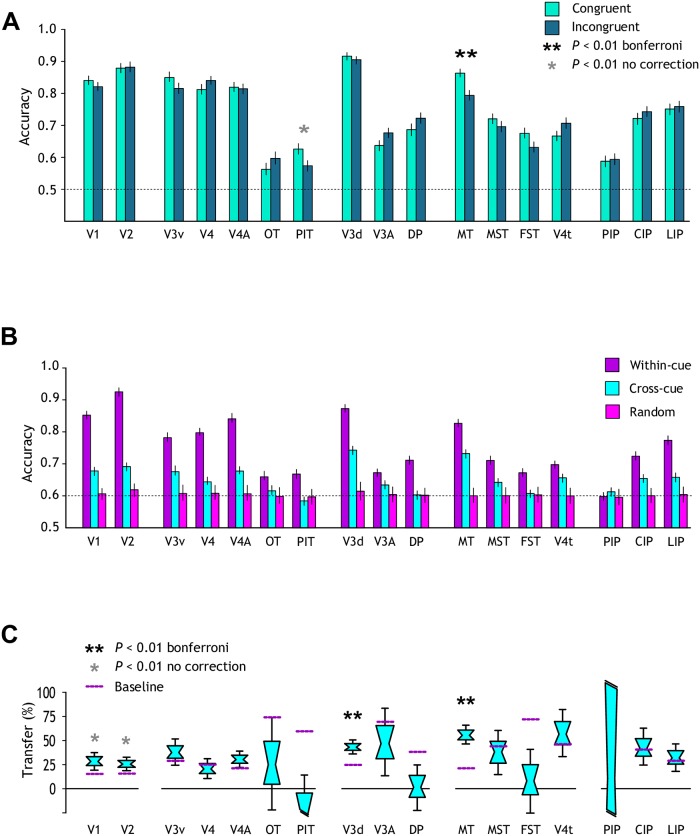
Congruency and transfer test.(A) Prediction accuracy for near versus far classification when cues are congruent or incongruent in different ROIs. The horizontal line at 0.5 corresponds to chance performance. Error bars, SEM; *P < 0.01 uncorrected; **P < 0.01 Bonferroni corrected. (B) Prediction accuracy for the cross-cue transfer analysis in different regions. Classification performances are shown when data were trained and tested with the same cue (within-cue, dark purple), trained with one cue and tested with the other (cross-cue, cyan), and for randomly permuted data (light purple). Error bars, SEM. (C) Data shown as a transfer index. A value of 100% would indicate that prediction accuracies were equivalent for within- and between-cue testing. Distribution plots show the median; cyan area and error bars represent the 68% and 95% confidence intervals, respectively. Purple dotted horizontal lines depict a bootstrapped chance baseline based on the upper 95th percentile for transfer obtained with randomly permuted data. *P < 0.01 uncorrected; **P < 0.01 Bonferroni corrected. The underlying data for the figures can be found at https://doi.org/10.5061/dryad.6pm117m. CIP, caudal intraparietal area; DP, dorsal prelunate area; FST, fundus of the superior temporal sulcus area; LIP, lateral intraparietal area; MST, medial superior temporal sulcus area; MT, middle temporal area; OT, occipitotemporal area; PIP, posterior intraparietal area; PIT, posterior inferotemporal area; ROI, region of interest.